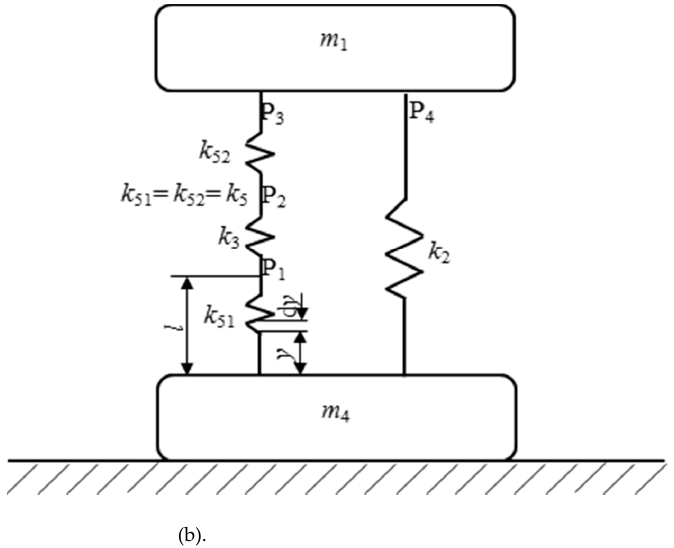
Figure 4. The strain gauge-based dynamometer design involves ( a ). Decomposition of the main structure ( b ). Physical model of the main structure.